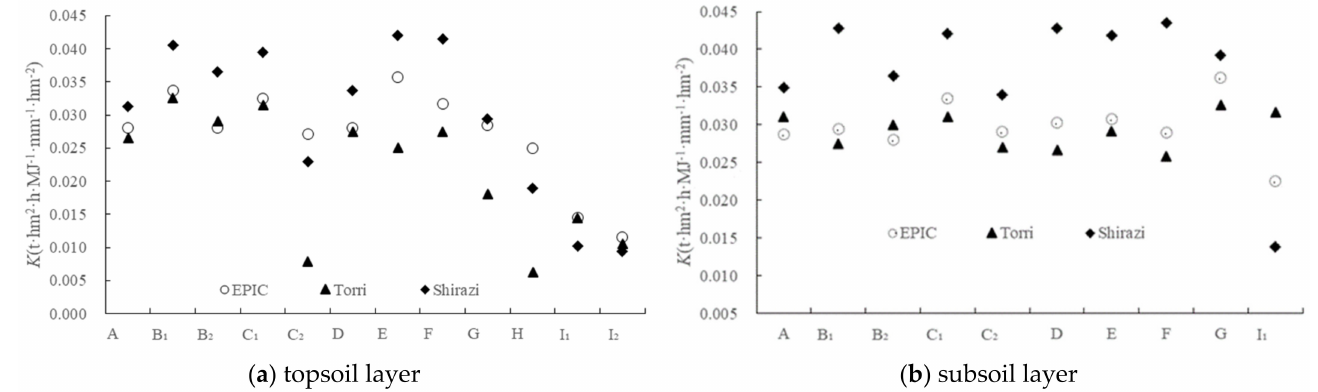
Figure 6. K values of different soil depths with model